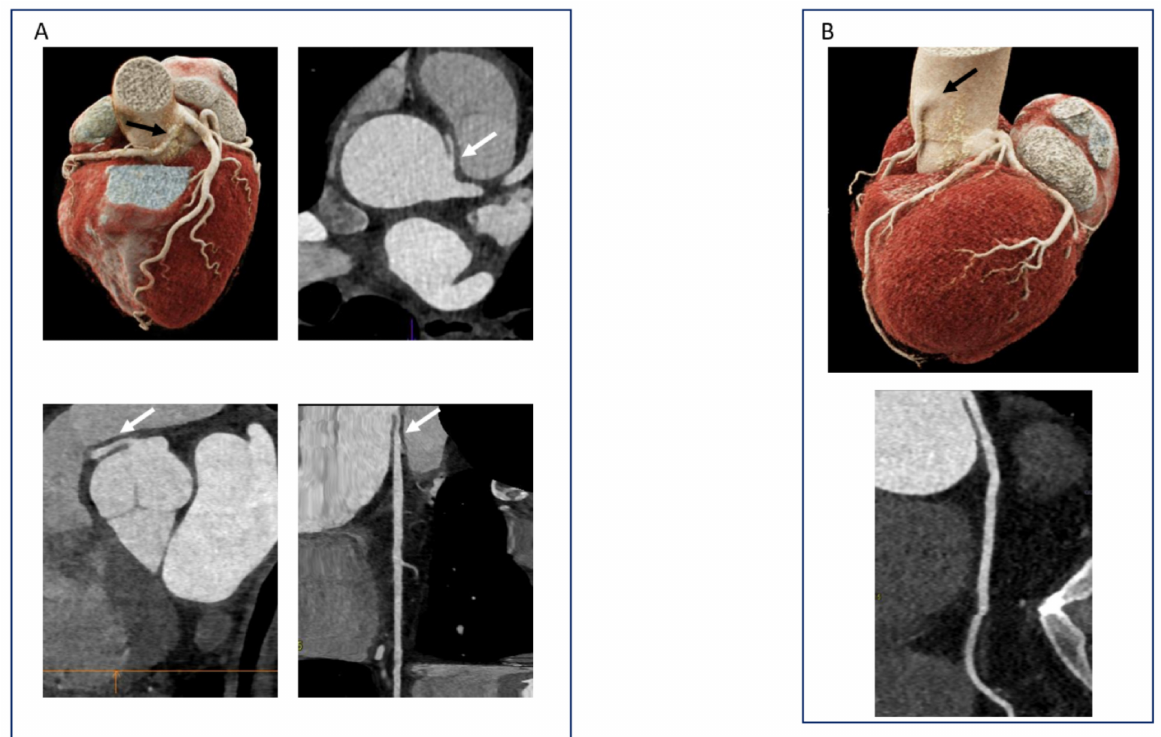
Figure 12. CCTA in the evaluation of coronary anomalies. ( A ). Patient with high-risk features of an RCA originating from the left coronary sinus: proximal narrowing, intramural trajectory, and course between the aorta and pulmonary artery. ( B ). Benign coronary anomaly with a high take-off of the